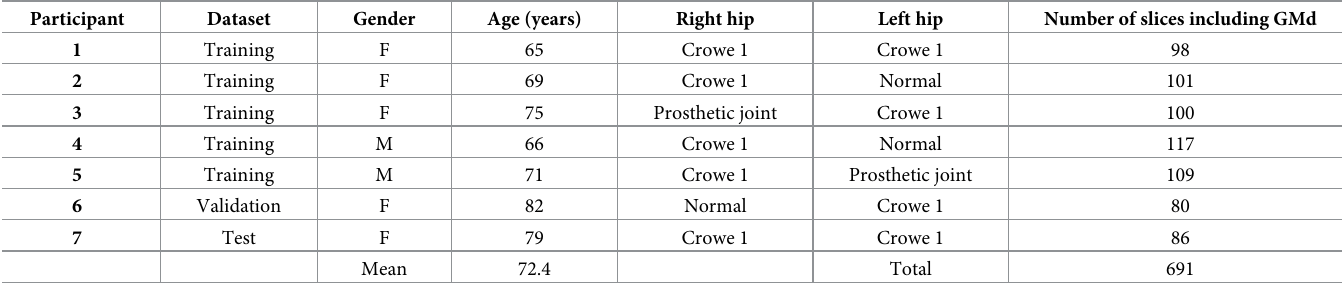
Table 1. Demographic and pathological characteristics of the seven participants.